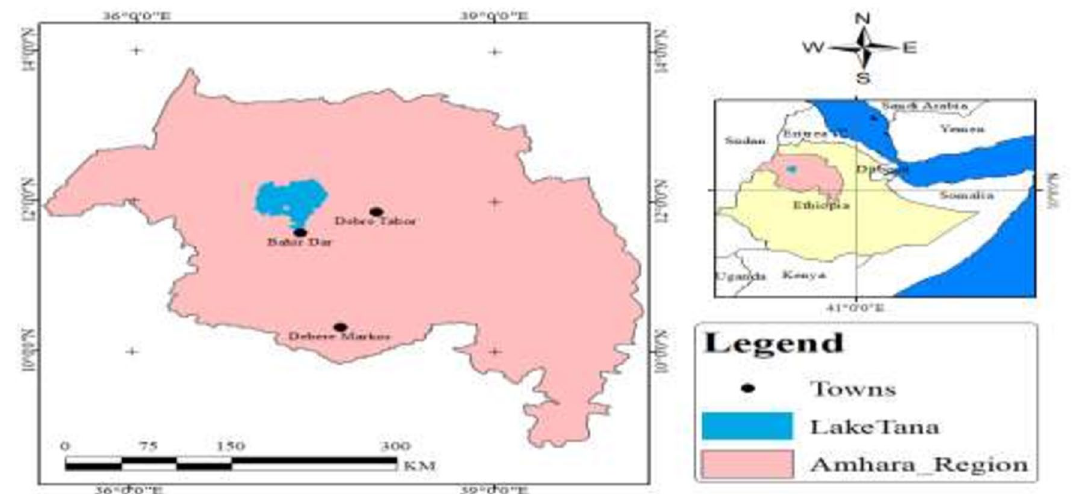
Figure 1. Map of the study area. ArcGIS software version 10.5, https:// njucl rd. weebly. com/ arcgis- 105- crack- free- downl oad.